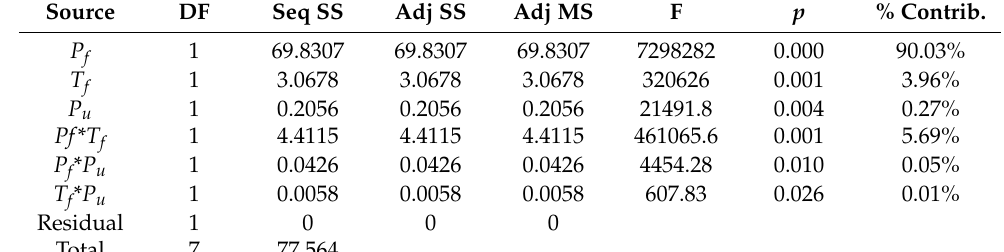
Table 10. Medium-carbon steel–304 SS ANOVA analysis for the signal-to-noise ratio (the larger the better).